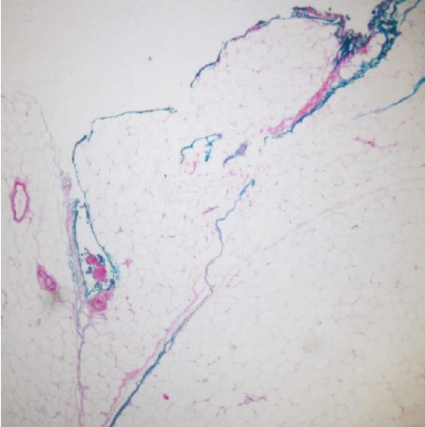
Figure 1: Penetration of ink between oil lobules (x40; H δ E).